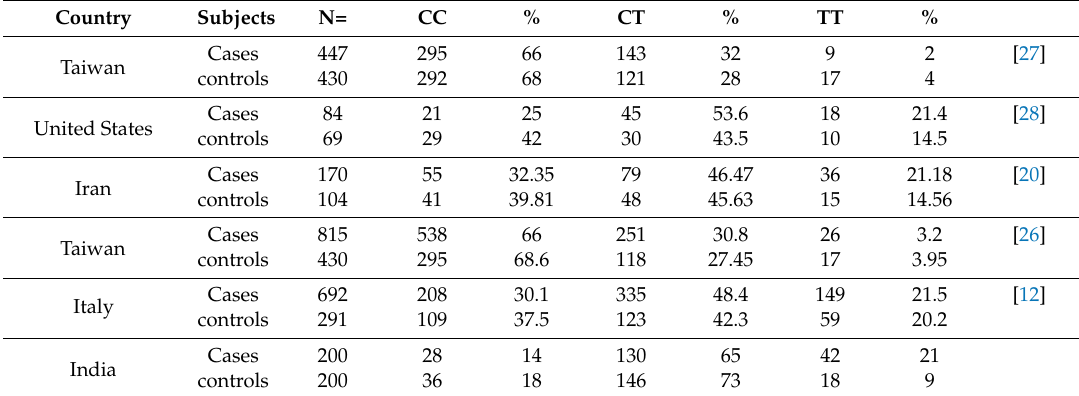
Table 7. Frequency of LDLR rs688C/T in different